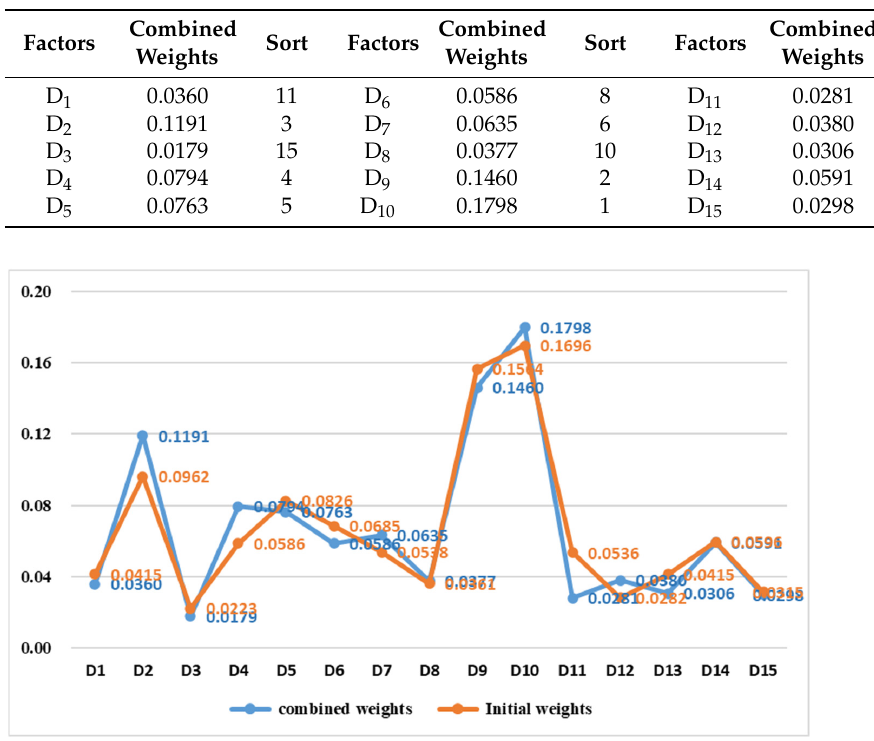
Figure 4. Initial, combined weights of driving factors.